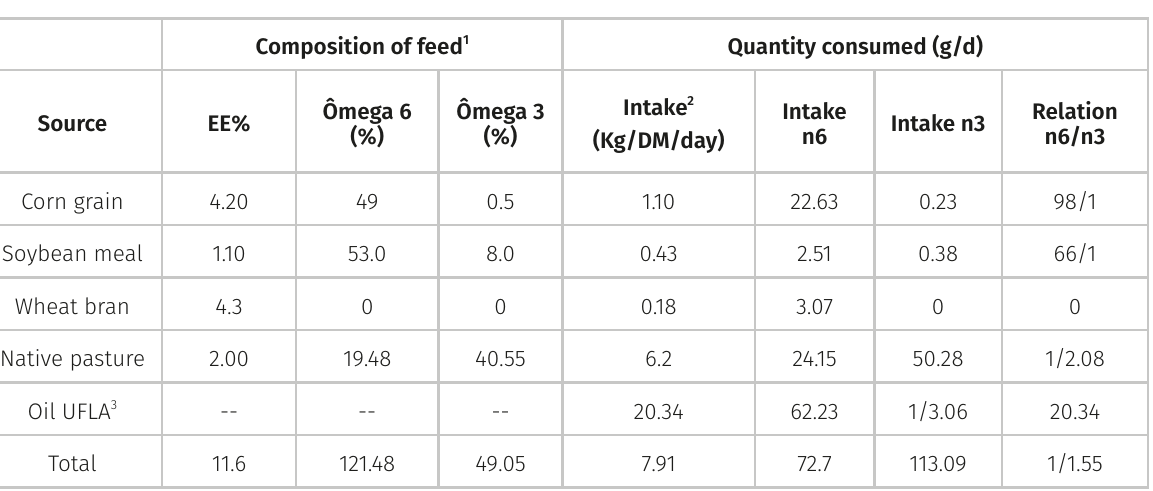
Table I. Estimation of PUFA concentration in the experimental diet*, on dry matter (DM)